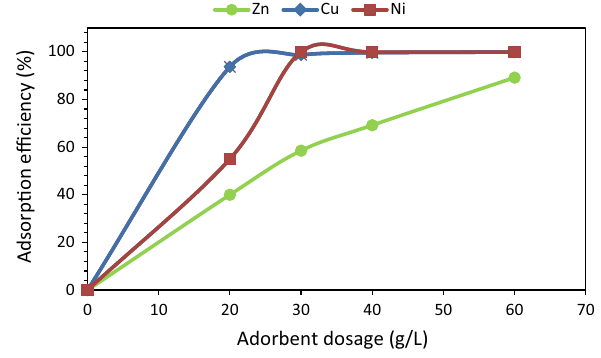
Fig. 4 Adsorption of heavy metals (copper, nickel and zinc) on red soil